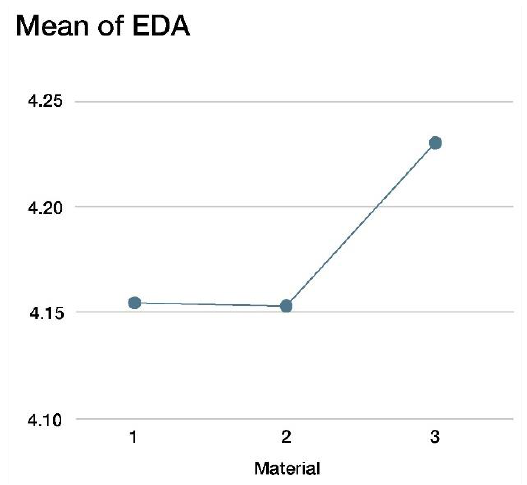
Figure 9. EDA response to various materials used in this study.